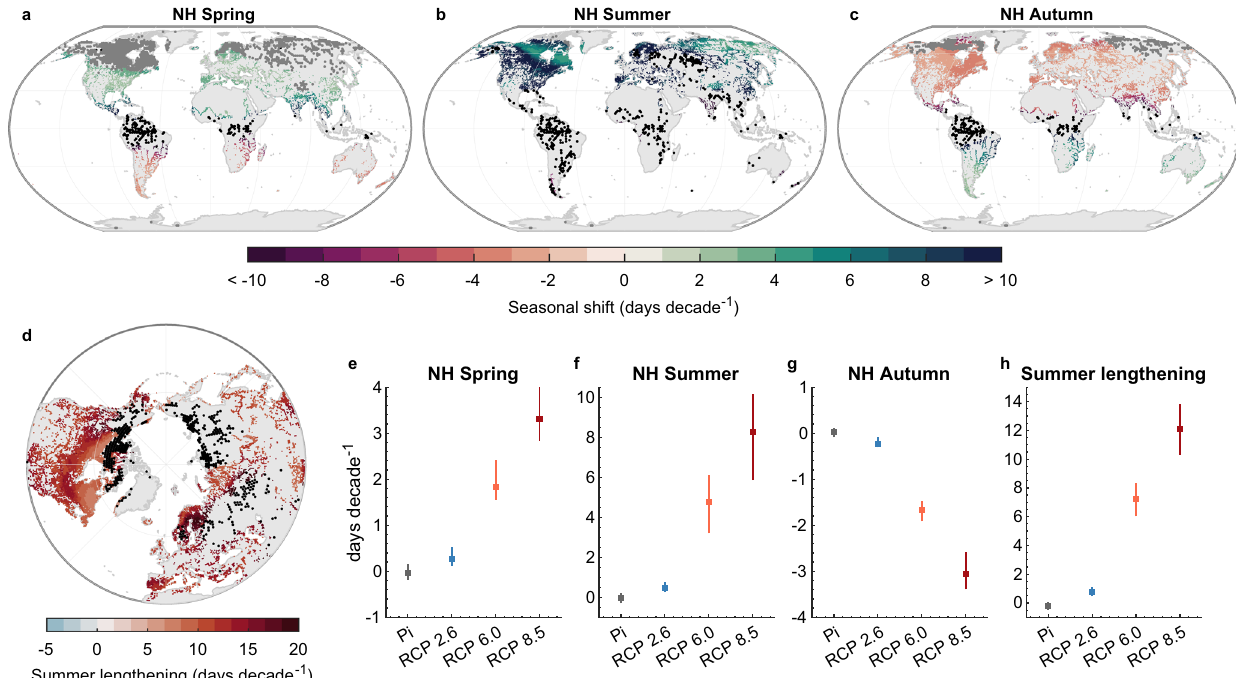
Fig. 4 | The pace of shifting seasons in lakes under future climate change. Shown are future (2021 – 2099) seasonal shifts (days decade − 1 ) in the timing of ( a ) spring (March – May in Northern Hemisphere [NH] and September – November in the Southern Hemisphere [SH]), b summer (June – August in the NH and March – May in SH) temperatures in lakes under Representative Concentration Pathway (RCP) 8.5. Positive and negative values indicate when the timing of a season will advance or be delayed, respectively. Also shown in panel d are pro- jected changes to the duration of summer under RCP 8.5, which was estimated as